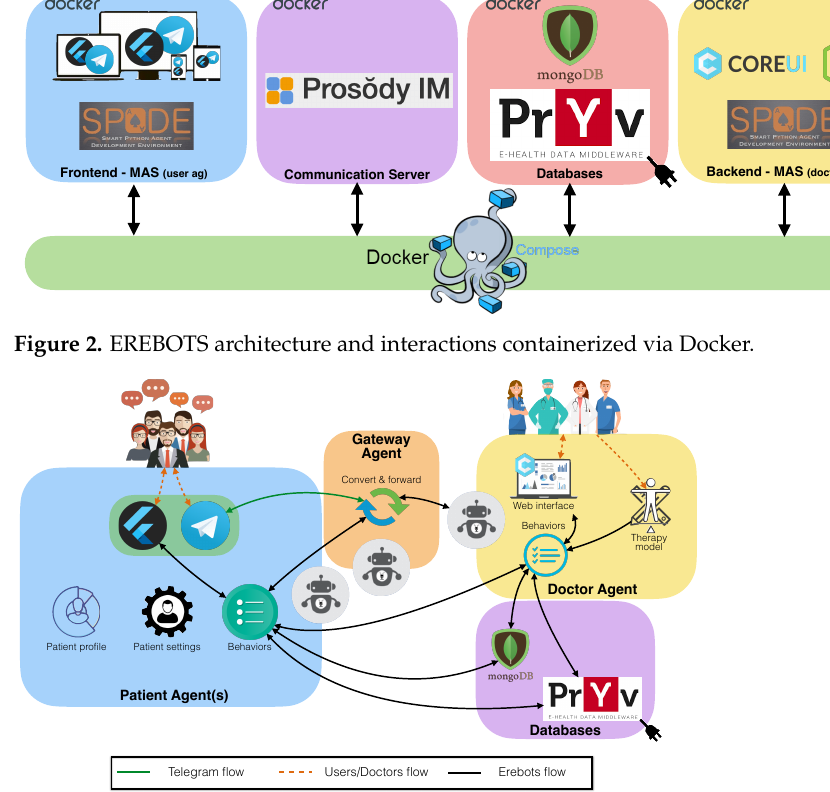
Figure 3. Main components, data stream, and agents’ interactions of the EREBOTS architecture. The framework comprises four main components: Database(s), Communication Server, MAS back-end for the doctor agents, and MAS for the user agents and front- end. Each of these components is deployed on a dedicated container and managed through Docker